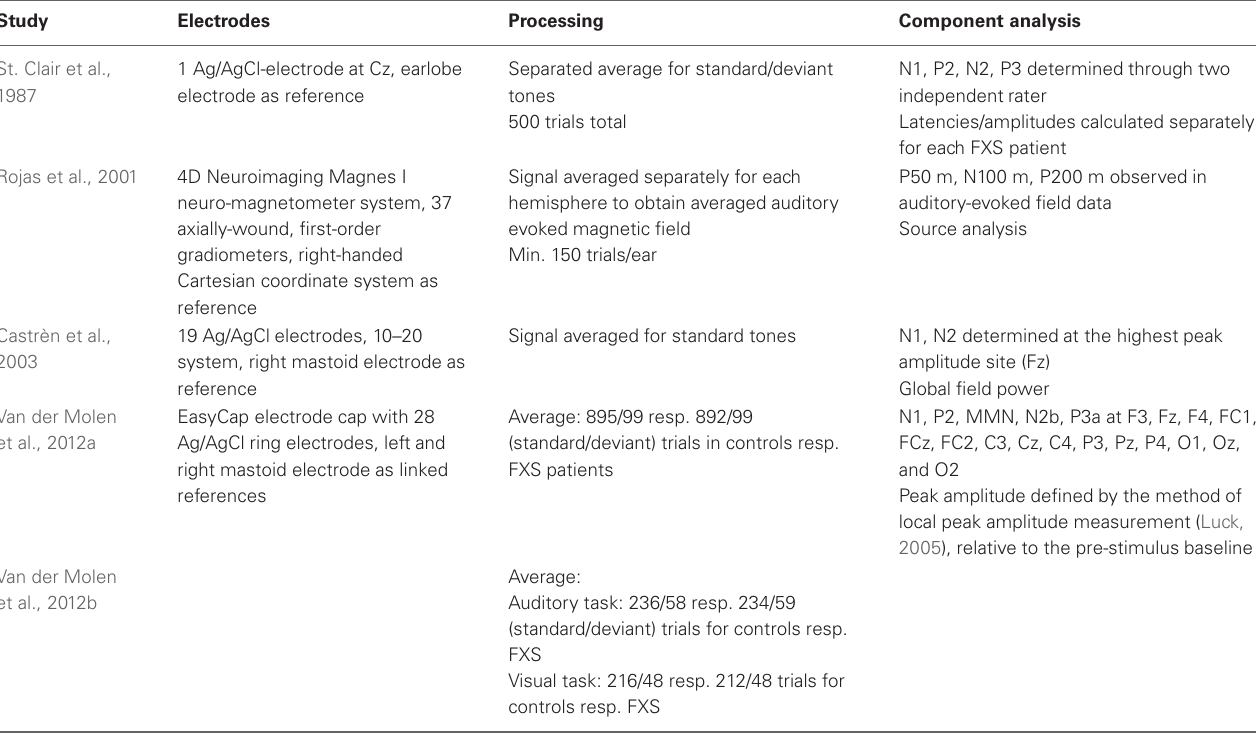
Table 4 | EEG/MEG registration and analysis in the reviewed